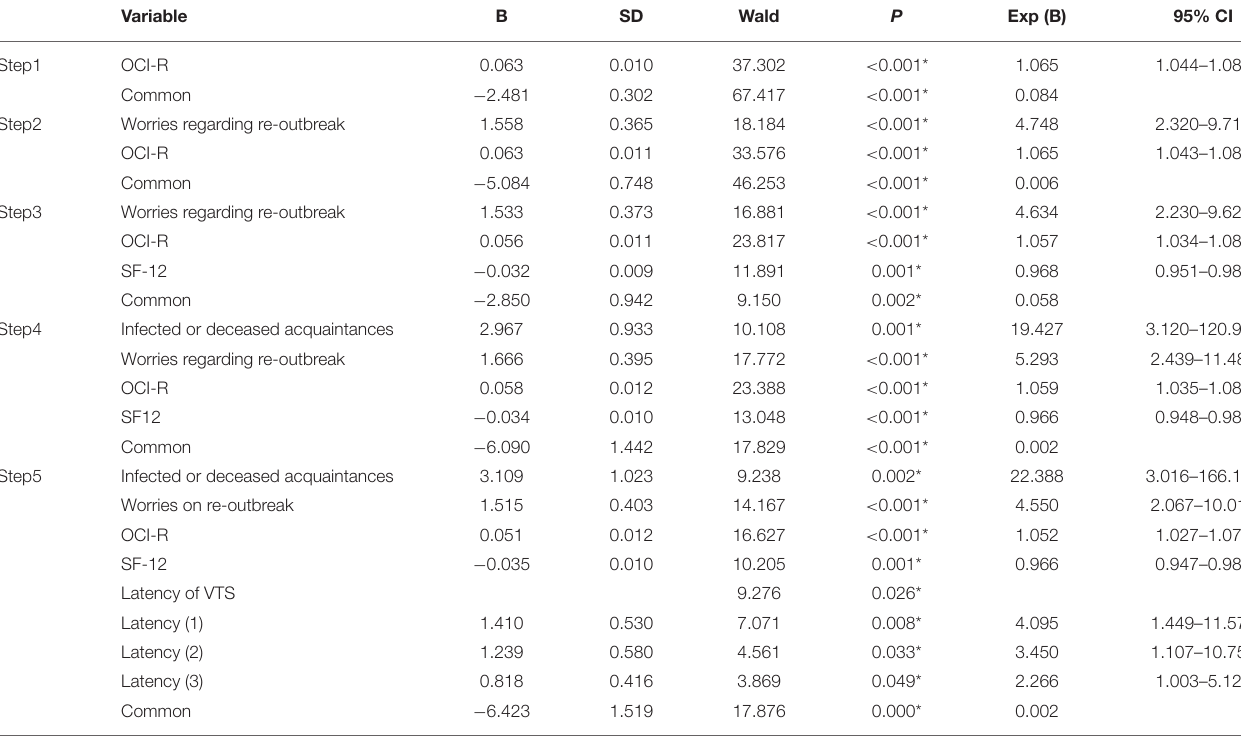
TABLE 4 | Multi-factorial logistic regression of variables relevant to